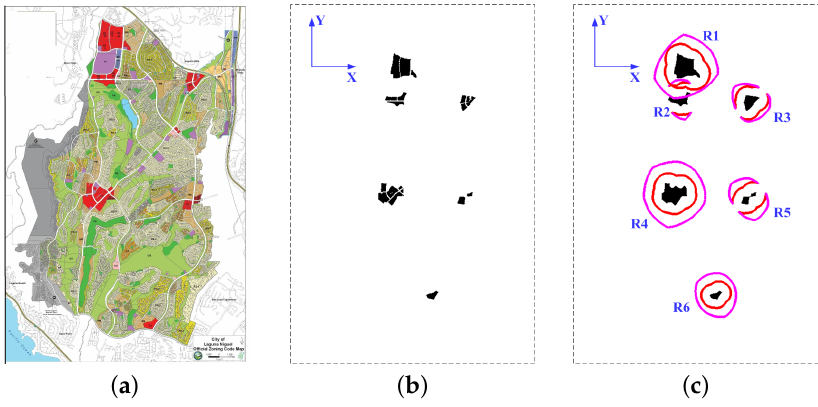
Figure 13. Pretreatment of the input map. ( a ) the input map image: the official zoning map of the city of Laguna Niguel; ( b ) binary image after ROI detection; ( c ) symbolic image after the image-based pretreatment